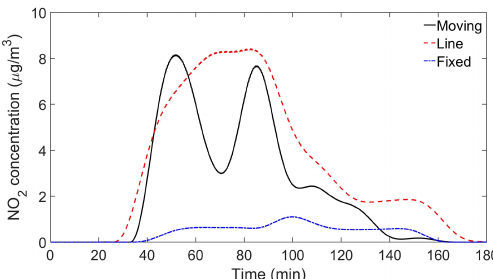
Figure 10. Time history of NO 2 concentration at the data point sim- ulated by using different emission source